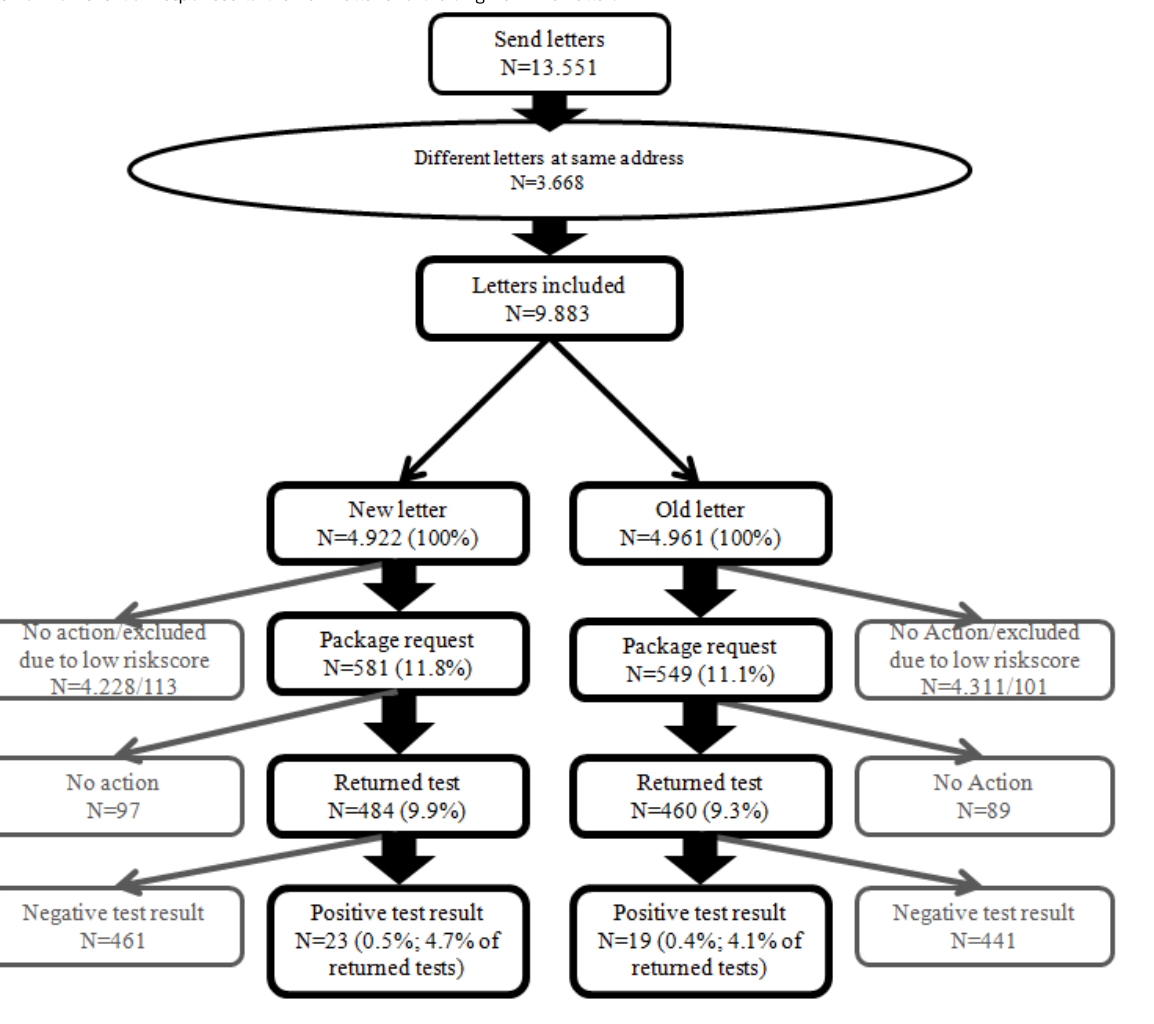
Figure 1. Flowchart of responses to the new letter and the original PHS